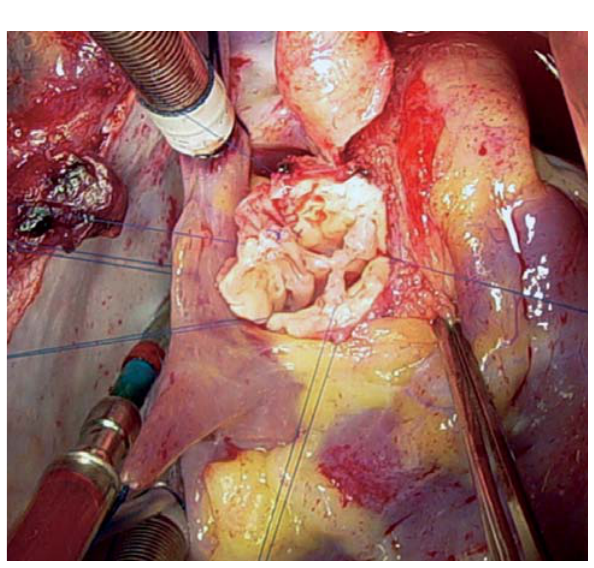
Fig. 2 - Porção aórtica proximal preparada para anastomose, com implante de